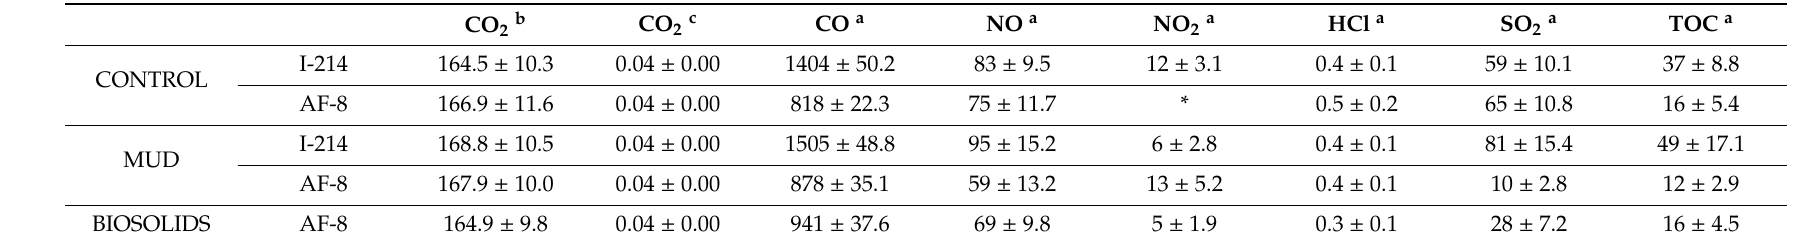
Table 3. Emission factors from flue